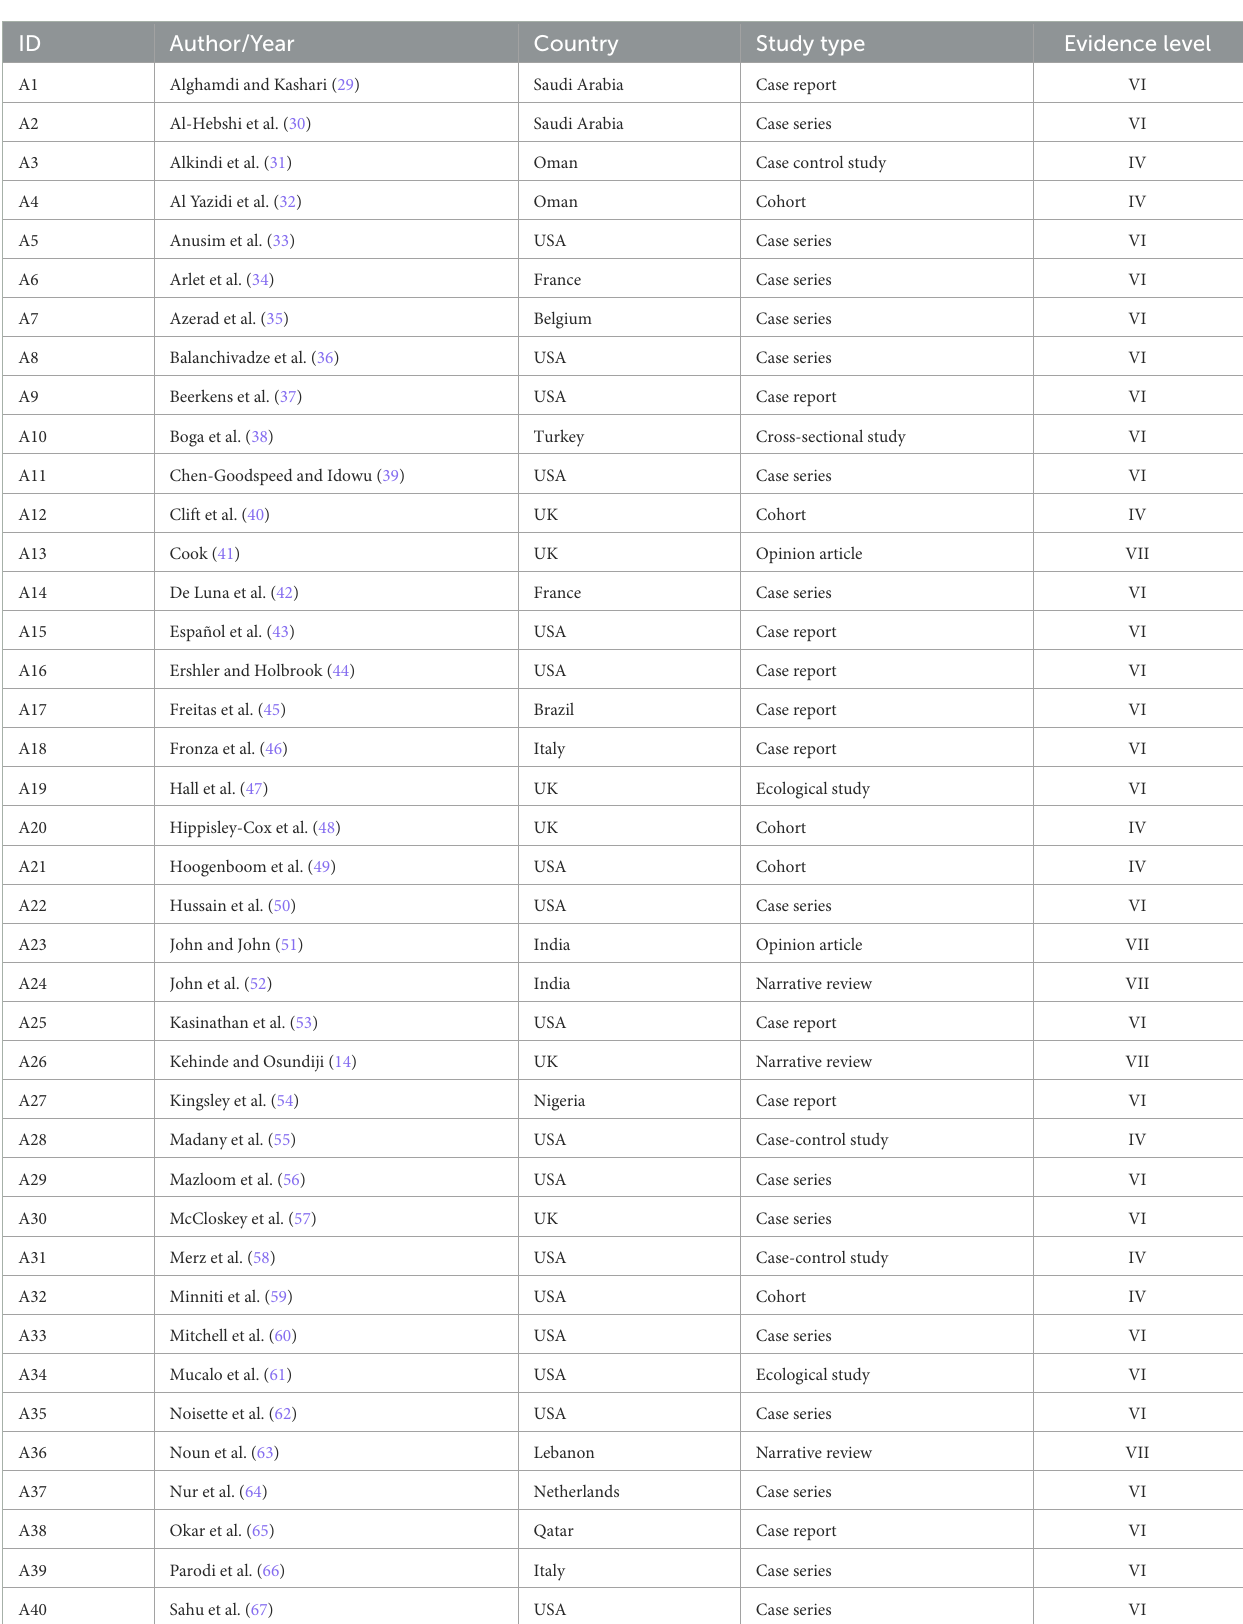
TABLE 3 Characterization of the 90 articles included in this integrative literature review, according to author/year of publication, origin country, type of study, level of